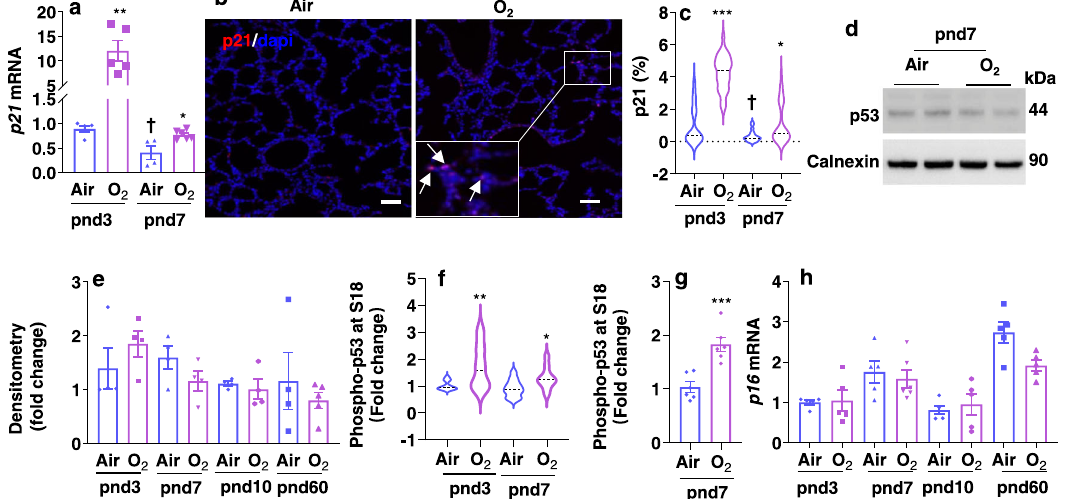
Fig. 2 | Neonatalhyperoxia increasesp21 expressionand p53phosphorylation in mouse lungs. C57BL/6J neonatal mice (<12h old) were exposed to air or hyperoxia (>95% O 2 ) for 3 days. Some mice were then allowed to recover in room air untilpnd60. a p21 mRNAwas measured using qRT-PCR in mouse lungs at pnd3 and pnd7. b Immuno fl uorescence was performed to determine expression of p21 protein. Representative images of p21 staining (red) in mouse lungs at pnd7. Arrows denote p21 positive cells. Bar size: 25 µ m. c Cells positive for p21 were countedandnormalizedtototalnumbersofnucleiinthelung. d p53proteinlevels were determinedby Westernblot in mouse lungs at pnd7. e Histogram shows p53